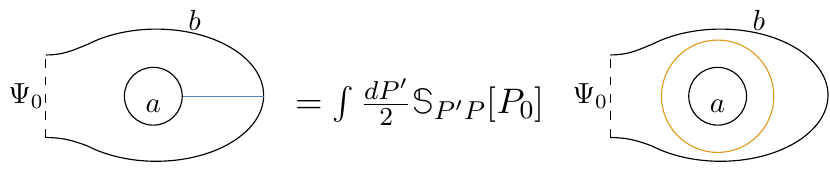
Figure 2 . The open-closed duality of the cylinder one-point function with an external (boundary) operator labelled by Ψ . The blocks on the two channels are related with a holomorphic copy of 0 the modular